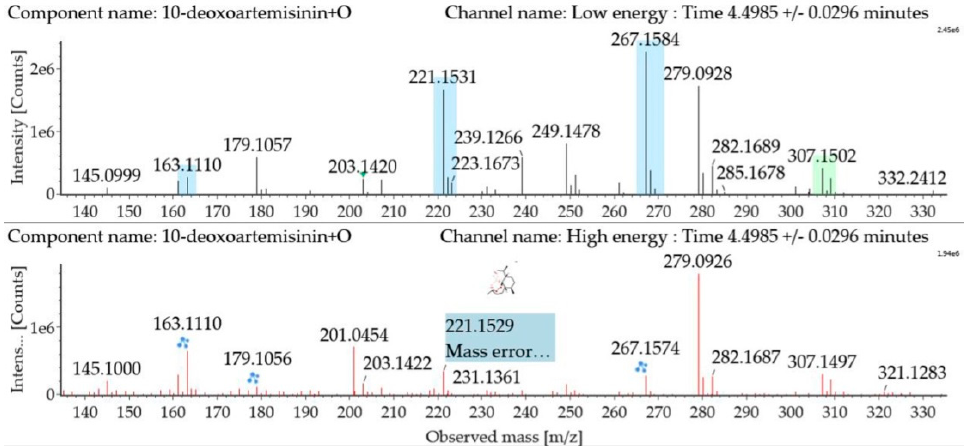
Figure 6. UPLC-ESI-Q-TOF-MS E spectra and the fragmentation diagram of monohydroxylated 10-deoxoartemisinin.